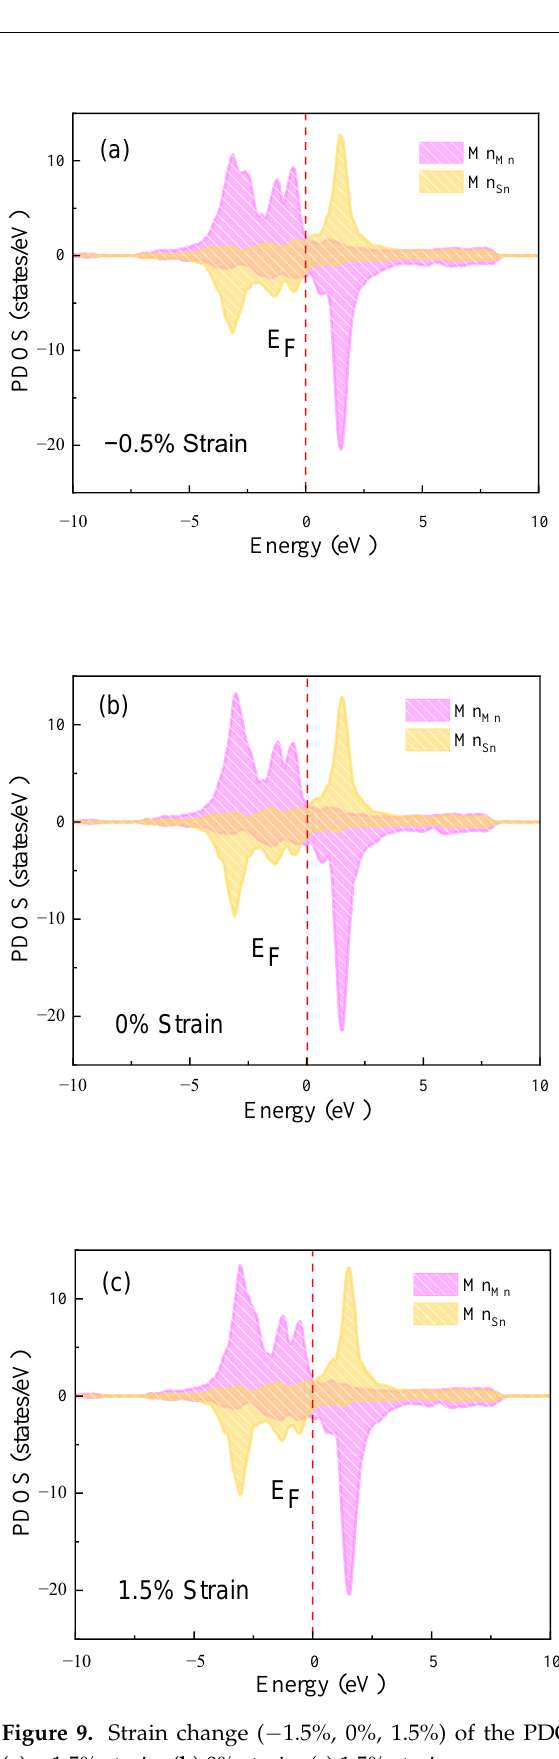
Figure 9. Strain change ( − 1.5%, 0%, 1.5%) of the PDOS of Ni 14 Co 2 Mn 13 Sn 3 martensitic phase. ( a ) − 1.5% strain, ( b ) 0% strain, ( c ) 1.5% strain.